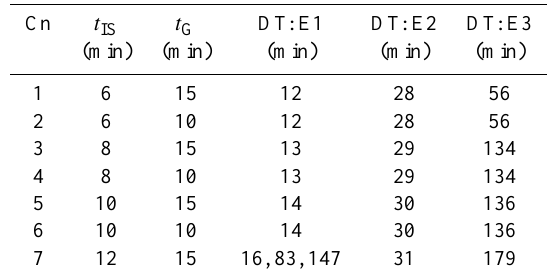
Table 8. TEDA secure detection results. All parameter combina- tions detect the same three events E1, E2 and E3, which are the ones with the largest amplitudes. The Delay Time DT, measured from tsunami arrival, seems to increase along with t IS and to increase as tsunami size decreases (see Table 3 to compare amplitudes, heights, and ranges of the three